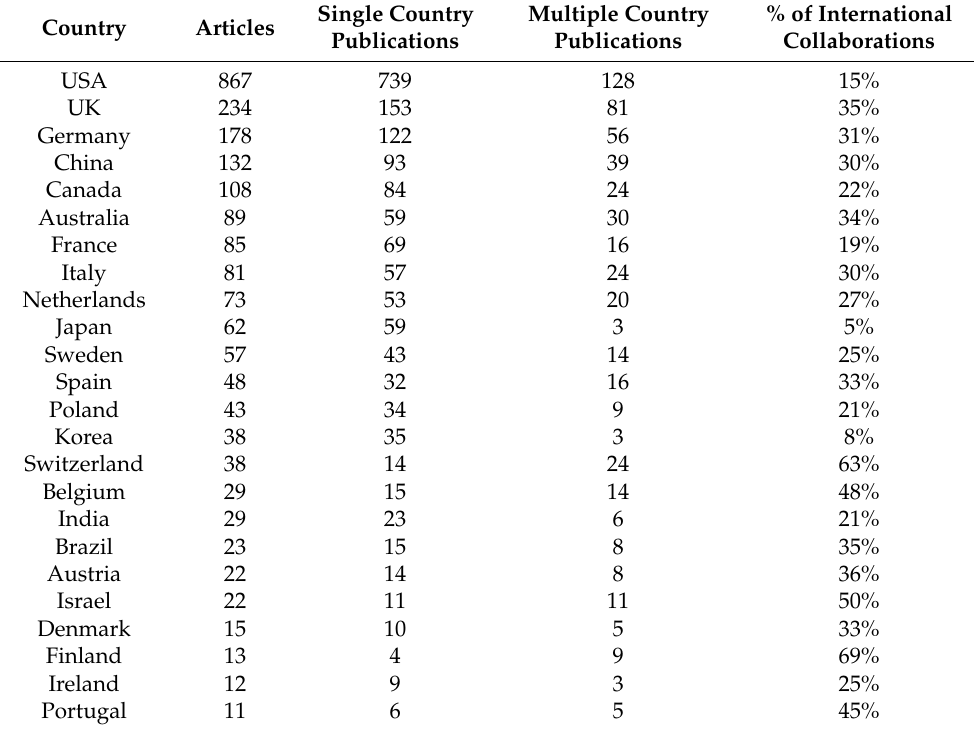
Table 1. Country-specific scientific